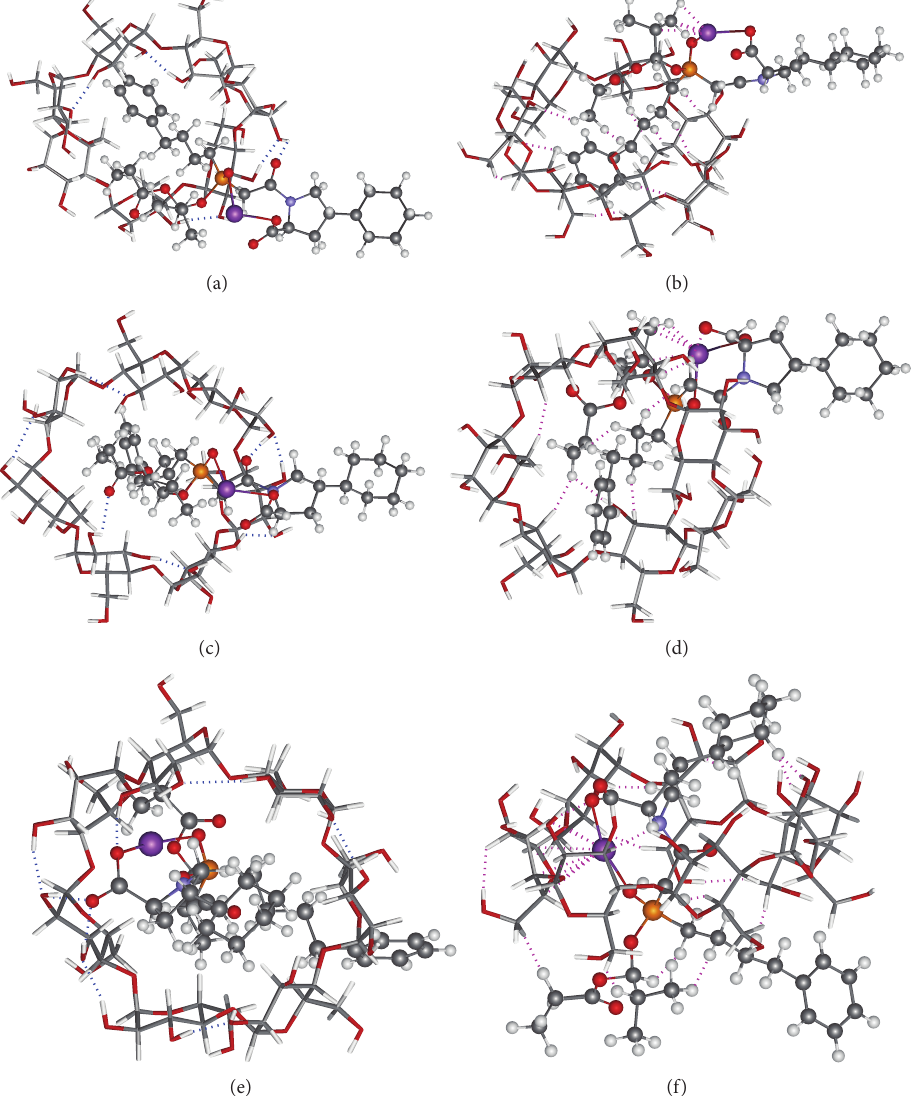
Figure 7: Structure views of the FOS/ 𝛽 -CD complexes with the Na salt form of fosinopril: hydrogen bond interactions (blue dashed lines) (a), (c), and (e) and van der Waals interactions (magenta dashed lines) (b), (d), and (f) for COONa type complexes 1 , 2 , and 3 , respectively.